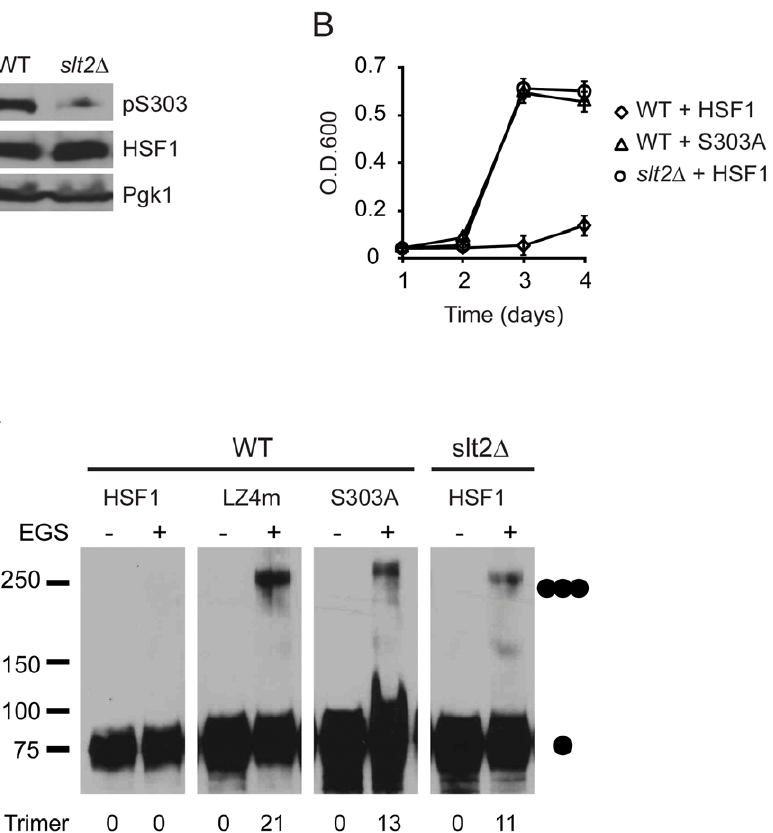
Figure 6. S303 phosphorylation of HSF1 in yeast is modulated by Slt2. ( A ) PS145 and LNY2 ( slt2 D ) were transformed with a plasmid expressing wild-type HSF1 and were grown on galactose containing medium. Total protein extracts were analyzed for pS303, total HSF1 and Pgk1 by immunoblotting. ( B ) PS145 (WT) expressing wild-type HSF1 or the S303A mutant or LNY2 ( slt2 D ) expressing wild-type HSF1 were grown in dextrose supplemented medium for 4 d. Growth was monitored by measuring O.D. 600 . ( C ) PS145 (WT) expressing wild-type HSF1, the LZ4m mutant or the S303A mutant and LNY2 ( slt2 D ) expressing HSF1 were evaluated for HSF1 multimerization by EGS cross-linking, SDS-PAGE, and immunoblotting. The positions of molecular weight markers are indicated on the left and circles indicating the expected migration of HSF1 monomers and trimers are on the right. Levels of HSF1 trimer as percent of total HSF1 are shown below.